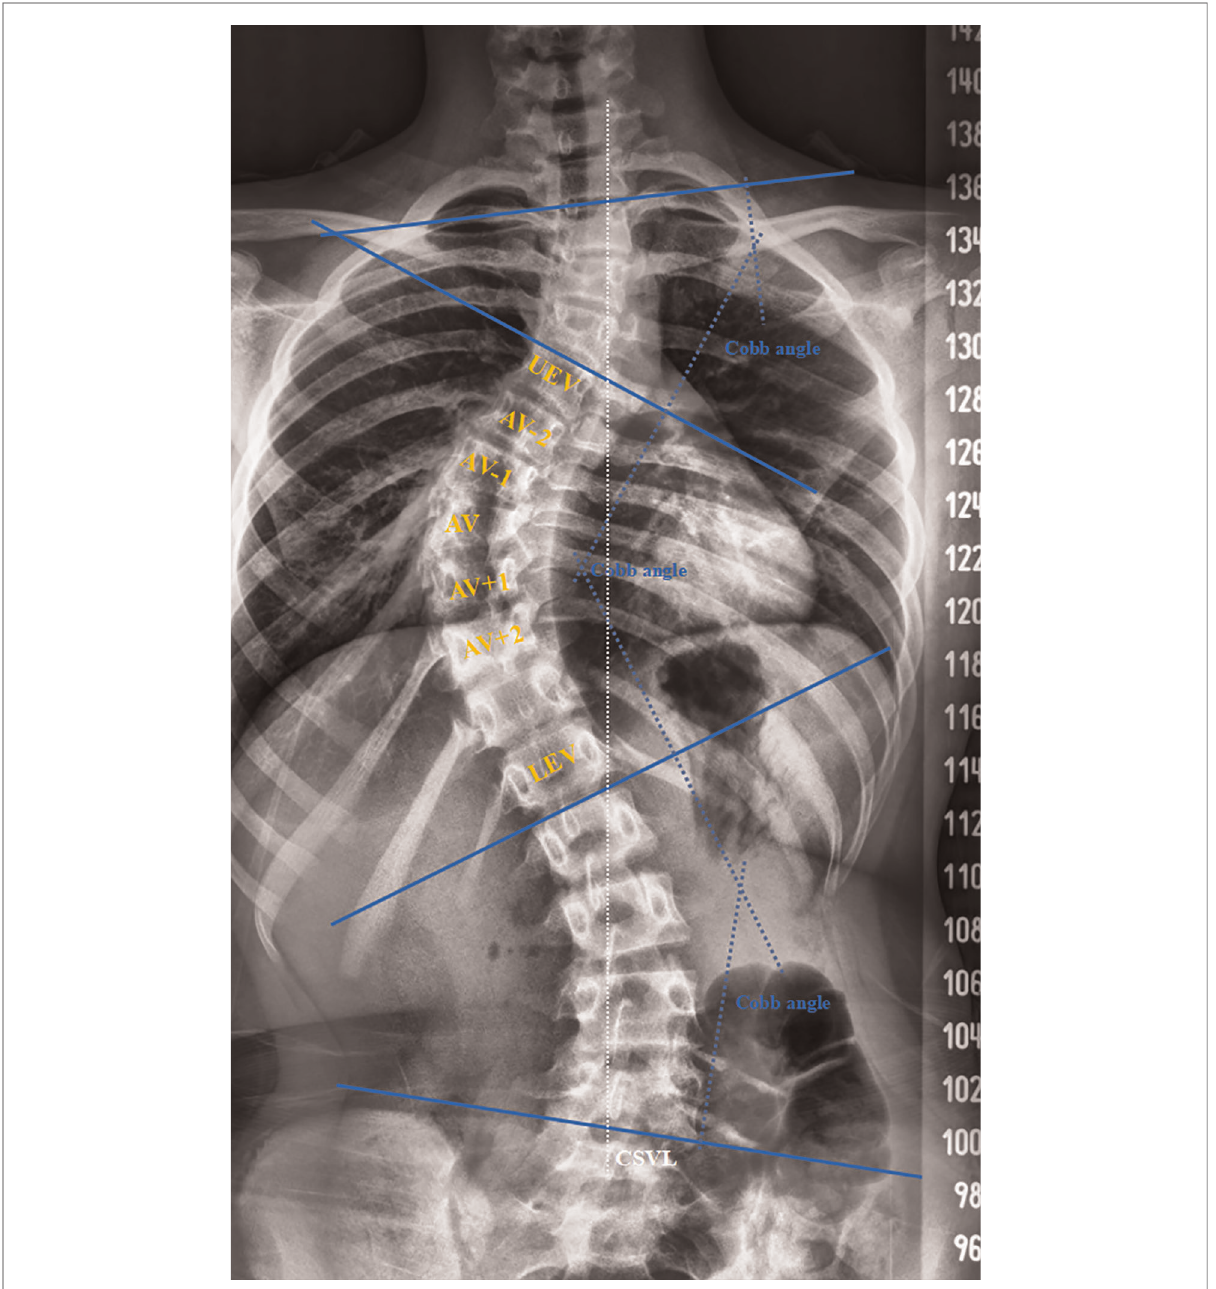
FIGURE 1 Measurement diagram of the AP x-ray of the whole spine. Three Cobb angles, including the structural and non-structural curves, was shown. The AV was de fi ned as the vertebral body farthest from the CSVL. If the intervertebral disc was located at the farthest position, we collected data from the upper and lower vertebrae at the same time, bringing two apical vertebrae into one apical region. AV-1 was de fi ned as the upper vertebra adjacent to AV; AV-2 was de fi ned as the upper vertebra adjacent to AV-1; AV+1 was de fi ned as the lower vertebra adjacent to AV; AV+2 was de fi ned as the lower vertebra adjacent to AV+1. The UEV and LEV were de fi ned as the vertebrae with the largest inclinations at the head and at the tail of the curve